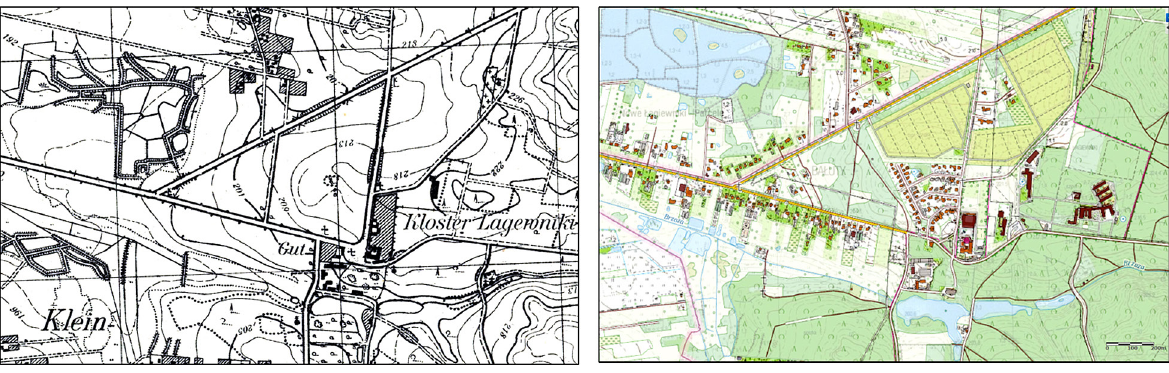
Fig. 5. Morphological changes in the former village of